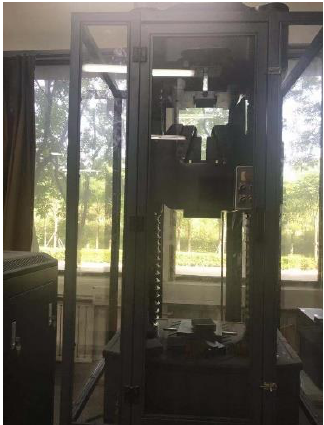
Figure 4. Equipment for testing.